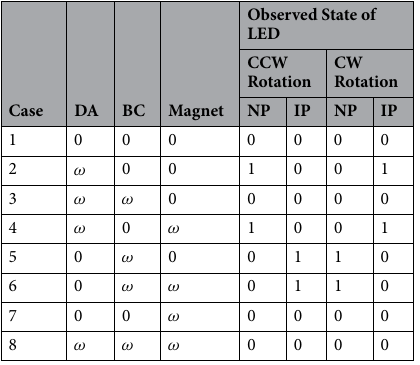
Table 3. Results for testing cases 1 to 8 in both rotational directions with both polarities of the amplifier. An ω indicates movement of the respective part and a 1 (true) represents an observed “on” state of the indicator LED, meaning a voltage is observed.